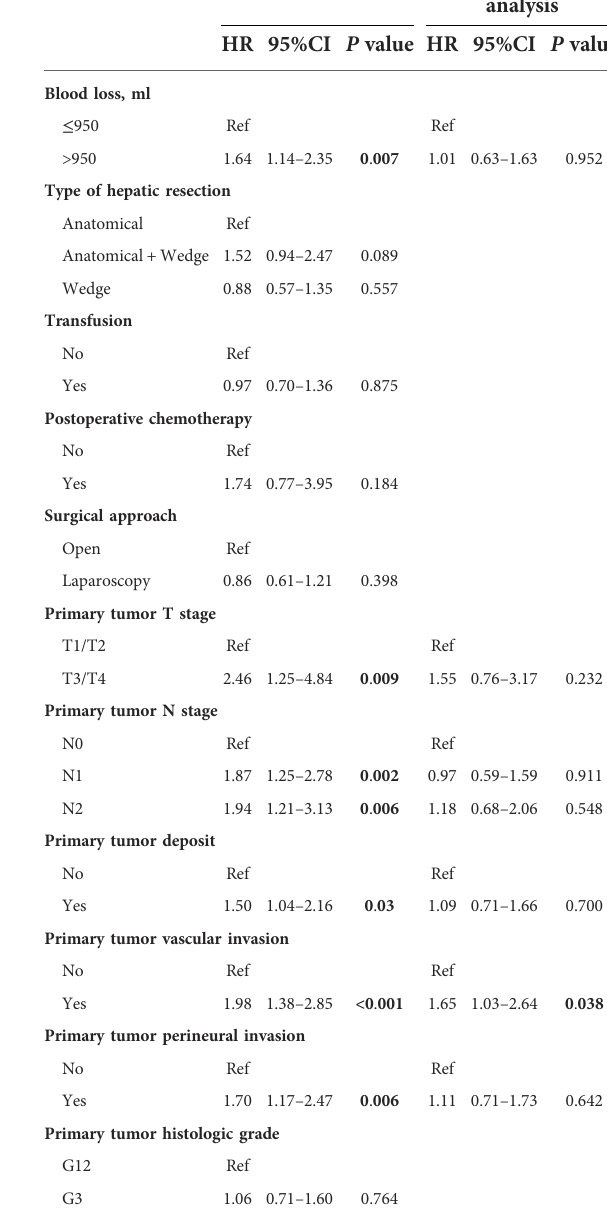
TABLE 3 Univariate and multivariable analysis of various clinical factors affecting the disease-free survival of the entire cohort. Univariate analysis